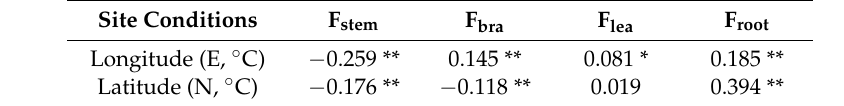
Table 2. Organ biomass and forest biomass (Mg ha − 1 ) and organ mass fraction. Organ Stem